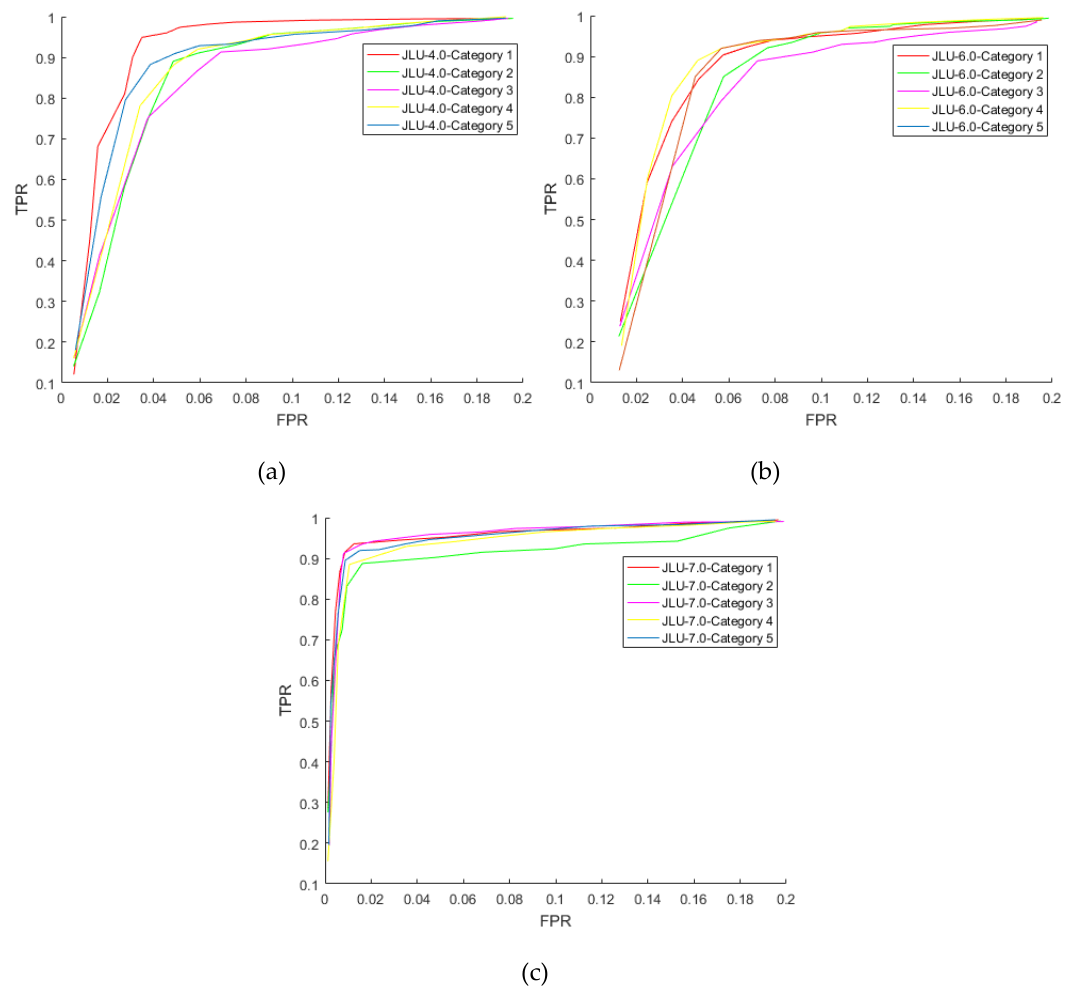
Figure 27. ROC curves of one-to-one certification of each category of the three iris libraries, ( a ) 4.0, ( b ) 6.0, ( c ) 7.0. Table 17. Certification times of each category in different iris libraries. The same Category Different Category